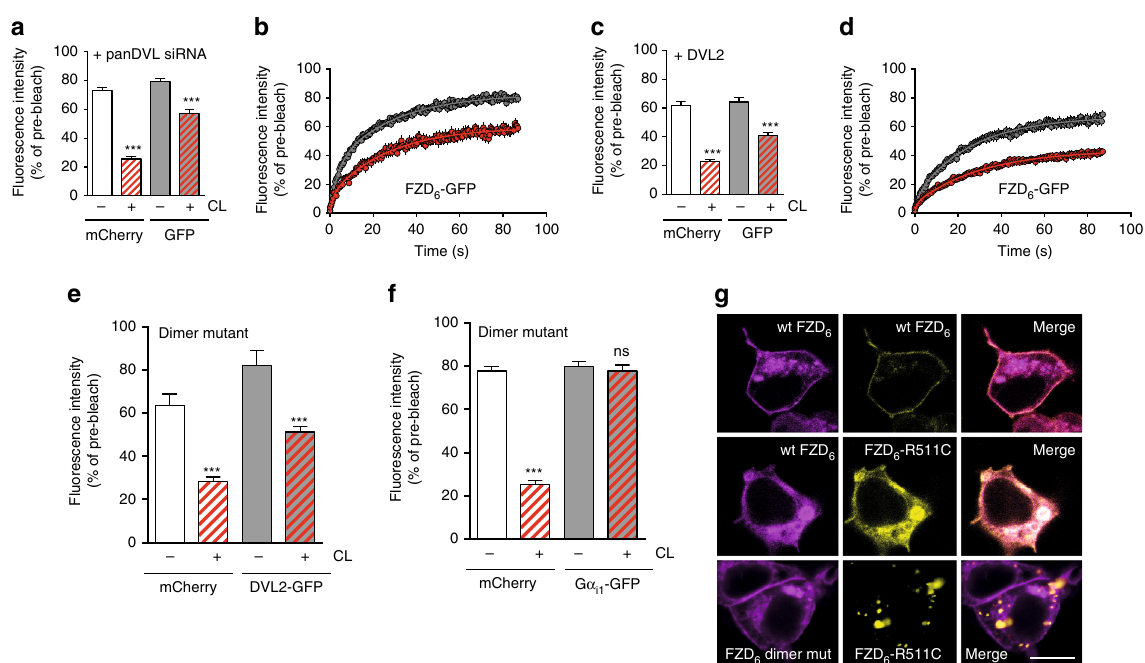
Fig. 4 Absence of a role for DVL and G proteins in FZD 6 dimer formation. a – d Analogous to data shown in Fig. 1c, d, we investigated the effect of V5-FZD 6 -mCherry surface crosslinking (CL) on the mobility of FZD 6 -GFP in the presence of a , b pan-DVL siRNA ( P < 0.0001; t = 6.854; df = 53; N = 33 ROIs before CL; N = 22 after CL from three independent experiments) and c , d overexpressed DVL2-MYC ( P < 0.0001; t = 6.243; df = 77; N = 36 ROIs before CL; N = 43 after CL from three independent experiments). e , f dcFRAP experiments in combination with chemical surface crosslinking show that the FZD 6 dimer mutant is still capable of assembling in an inactive state with DVL2-GFP ( P < 0.0001; t = 5.173; df = 74; N = 15 ROIs before CL; N = 61 after CL from three independent experiments), but not with G α i1 -GFP ( P = 0.5646; t = 0.5801; df = 48; N = 29 ROIs before CL; N = 21 after CL from three independent experiments). Error bars give s.e.m.; *** P < 0.001; ns non signi fi cant (two-tailed t -test). g V5-FZD 6 -mCherry and FZD 6 -GFP expressed in HEK293 cells showed distinct co-localization predominantly in the membrane. The FZD 6 -R511C mutation (predominantly localized to lysosomes and unable to interact with heterotrimeric G proteins 16,25 ) forced the wt FZD 6 to be retained intracellularly suggestive of dimer formation. Co-expression of the FZD 6 -R511C mutant together with the dimer mutant of FZD 6 did not result in co-localization. Due to the lack of dimerization, the FZD 6 dimer mutant showed surface expression in the presence of FZD 6 -R511C. Size bar — 10 µ